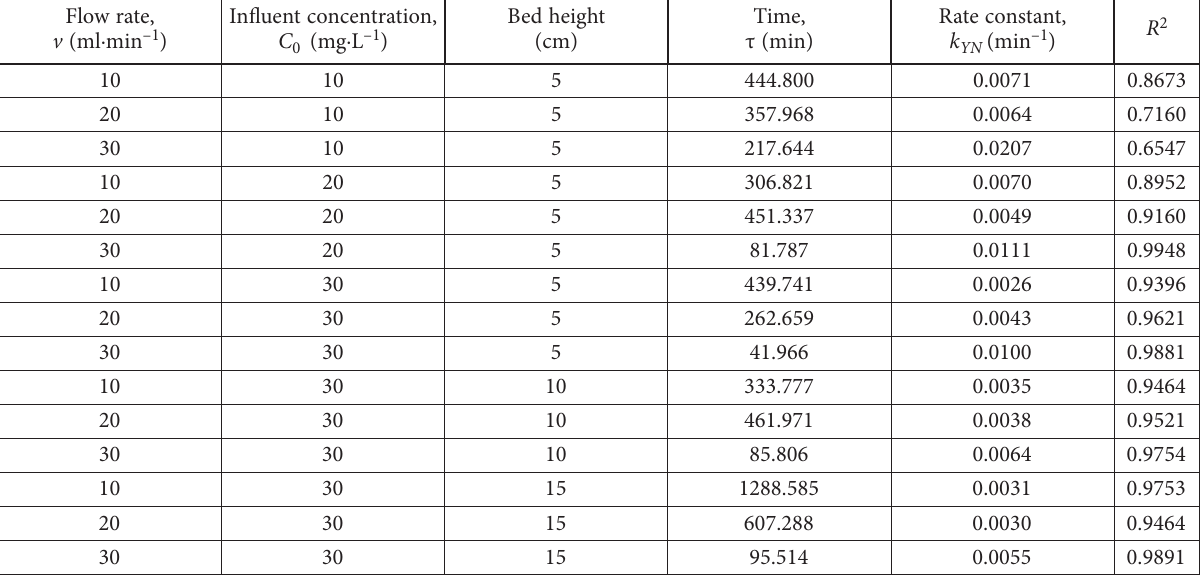
Table 2. Yoon-Nelson model parameters using linear regression analysis